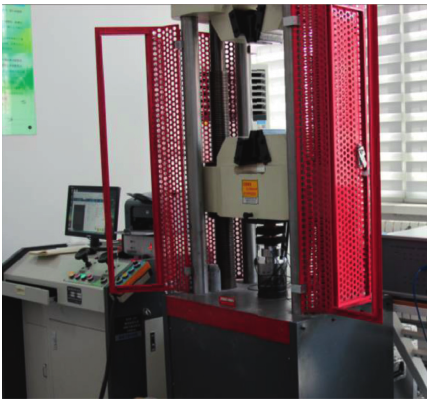
Figure 2: Rock mechanics test system.